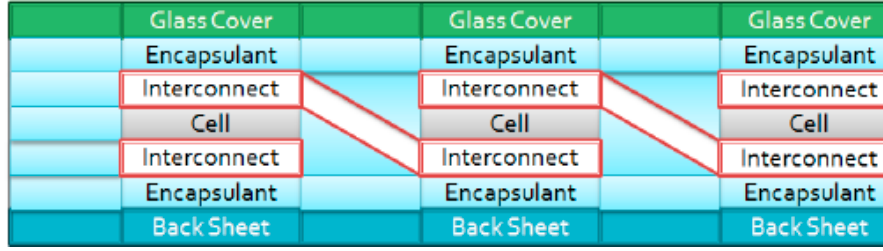
Figure 9. Cross section of a PV module